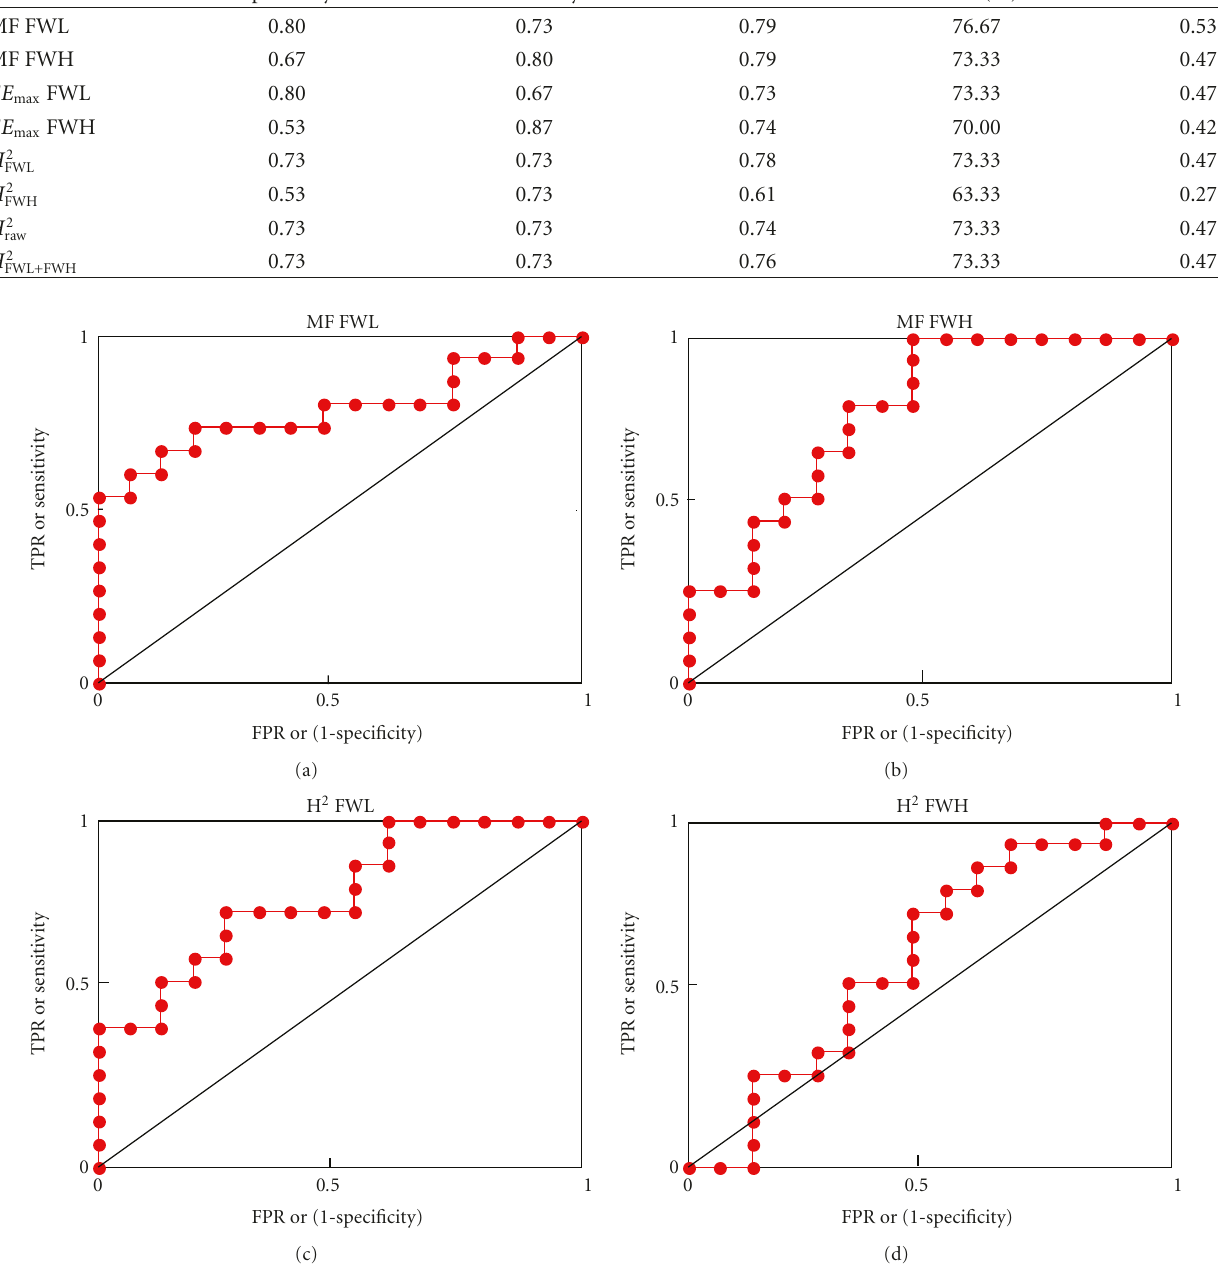
Figure 6: Examples of ROC curves obtained with di ff erent parameters for labor prediction. TPR and FPR stand for True Positive Rate and False Positive Rate,